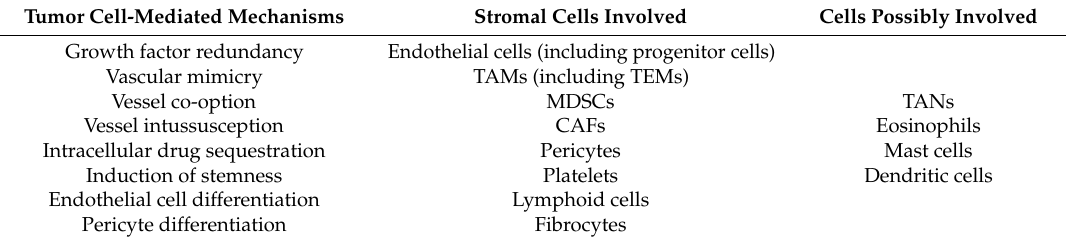
Table 1. The list of tumor cell-mediated mechanisms and stromal cell types involved in the resistance to anti-angiogenic